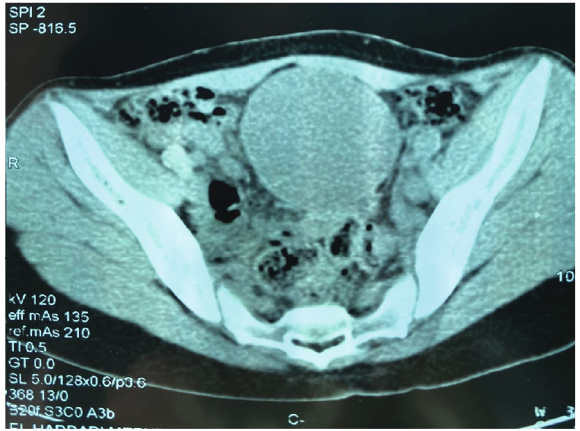
Figure 1: Abdominal computed tomography scan showing abdominopelvic mass.